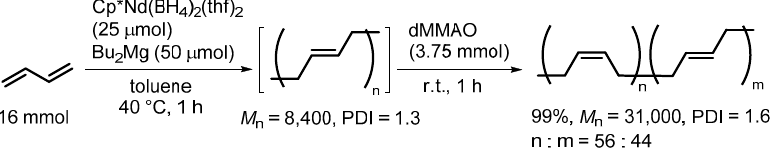
Figure 5. 13 C NMR spectrum (125 MHz, in CDCl 3 ) of trans ‐ 1,4 prepolymer ( above ) and stereodiblock polybutadiene synthesized in Scheme 2 ( below ).